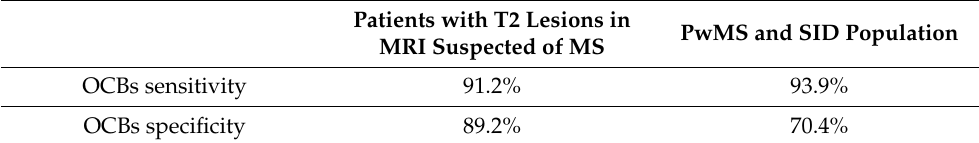
Table 2. Diagnostic sensitivity and specificity of OCBs.